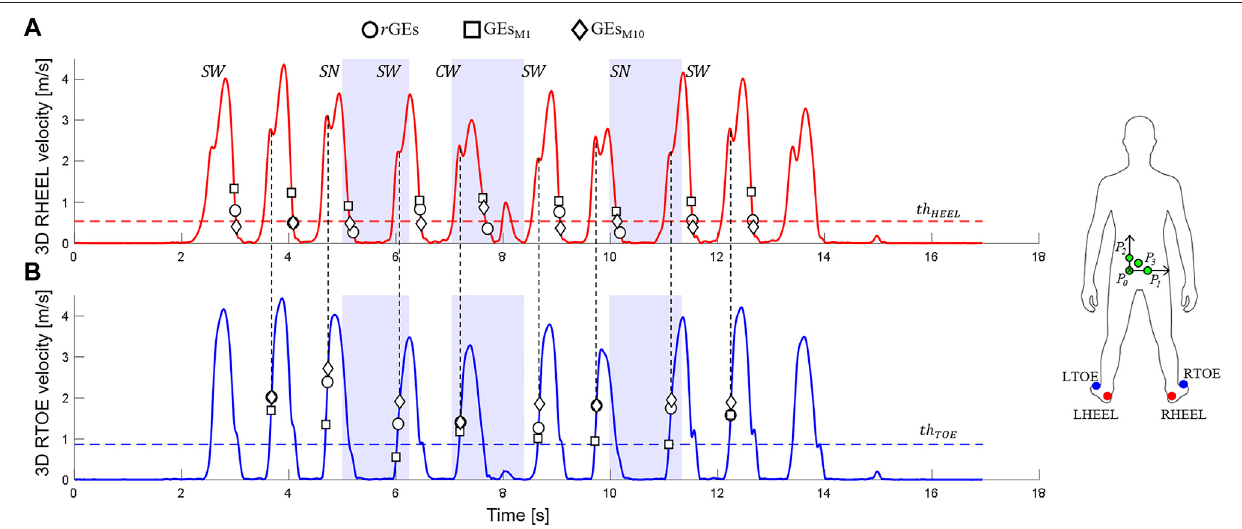
FIGURE 1 | 3D heel [in red, (A) ] and toe [in blue, (B) ] marker velocities (data from one participant performing a Hallway test, 2.3 section) are shown. Relevant ground-truth (circles, r GEs) and marker-based GEs (squares for the M1 method, GEs M1 ; diamonds for the M10 method, GEsM 10 ) are indicated together with the adopted thresholds ( th HEEL and th TOE ). Straight-line walking ( SW ), curvilinear walking ( CW ), and step negotiation ( SN ) portions are highlighted with light blue rectangles. The fi gure also shows the adopted marker set (feet: LTOE, RTOE, LHEEL, and RHEEL; pelvic markers: P 0 , P 1 , P 2 , and P 3 ) and pelvic axes [medio-lateral(ML) axis: unit vector going from P 0 to P 1 , pointing to the right; anterior – posterior (AP) axis: unit vector orthogonal to the plane containing P 0 , P 1 , and P 3 and pointing forward; vertical axis (V): unit vector orthogonal ML and AP and pointing cranially].